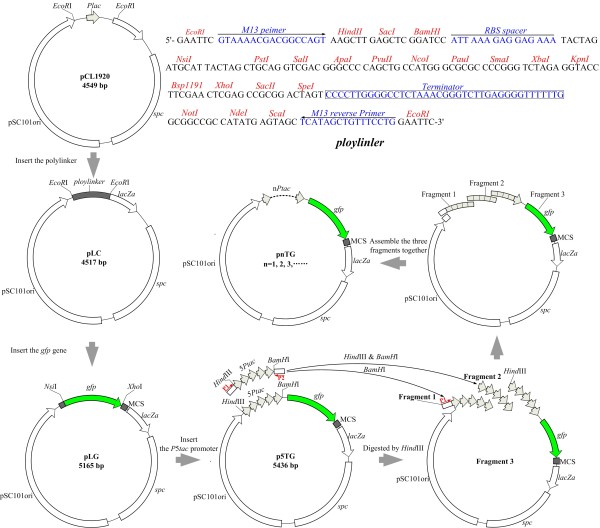
Construction outline of the MCPtacs promoter clusters. Fragment 5CPtacs with the flanking sequence was amplified by PCR with p5TG as the template. Fragment 1 was generated by digesting fragment 5CPtacs with BamHI. Fragment 2 was digested from fragment 5CPtacs with BamHI and HindIII. Fragment 3 was linearized from the plasmid p5TG with HindIII. Then, the three fragments were assembled together under the action of T5 exonuclease, Phusion DNA polymerase and Taq DNA ligase in the isothermal process.